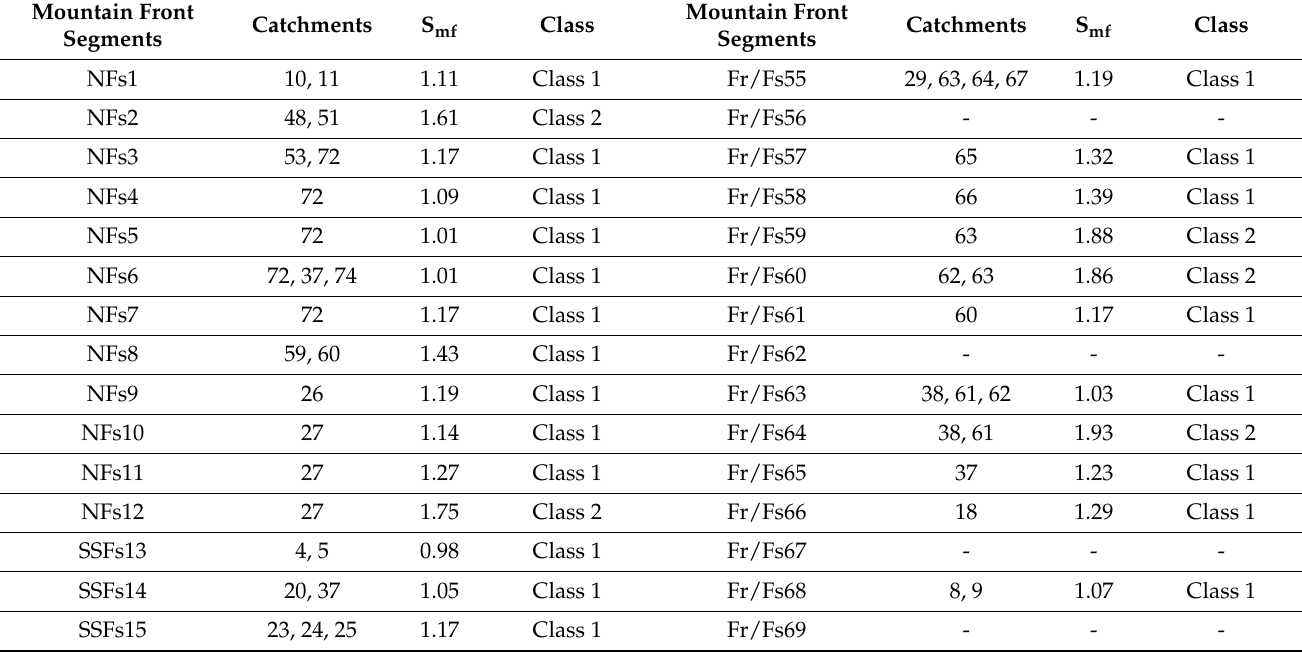
Table 1. Values and classes of S mf for 107 identified mountain front